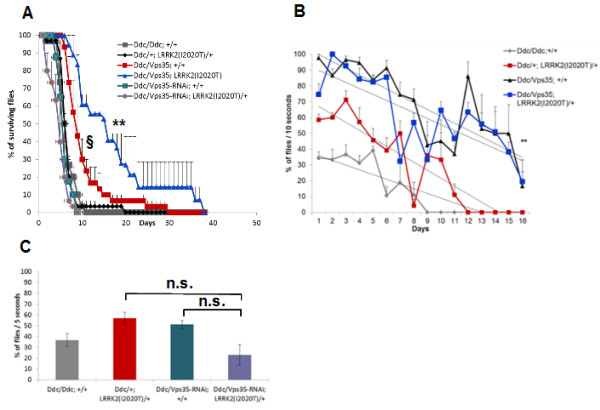
Effect of Vps35 overexpression and Vps35 knockdown on rotenone toxicity. A)Vps35 overexpression in DA neurons improves survival rates following exposure to rotenone, and LRRK2(I2020T) and Vps35 act synergistically to protect from rotenone. B)Vps35 overexpression in DA neurons protects from locomotor deficits seen in LRRK2(I2020T) or control flies exposed to rotenone. Knocking down Vps35 has no significant effect on survival (A), or locomotor activity (C). N = 20-40 flies/genotype. Statistical analysis by Two-Way ANOVA, Tukey’s post-test. Statistically significant difference compared to Ddc/+;LRRK2(I2020T) and control (Ddc alone) was denoted as * *for P < 0.001; statistically significant difference compared to control and compared to Ddc/Vps35;LRRK2(I2020T)/+was denoted as § for P < 0.05.